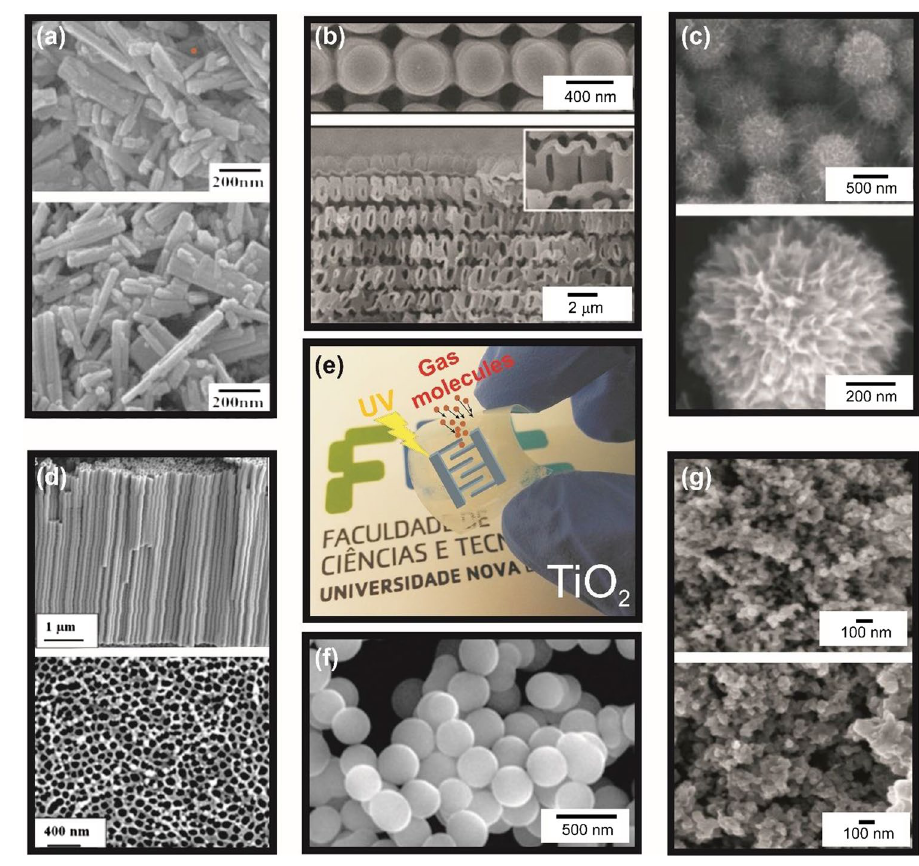
Fig. 2 SEM images of several TiO nanostructures 2 employed as sensing layers. a TiO nanotubes for toluene 2 sensing [57], b highly periodic 3D thin-shell TiO nanostruc- 2 tures for NO gas sensing 2 [58], c TiO 3D hierarchical 2 nanostructures for ethanol gas sensing [59], d TiO tubu- 2 lar layers for NO gas sensing 2 [60], e image representing a flexible sensor device adapted from [34], f TiO nanospheres 2 for ethanol and acetone gas sensing [61], g TiO nanopar- 2 ticles for NO gas sensing [62]. 2 Reprinted with permission from “Large scale synthesis and gas-sensing properties of anatase TiO three-dimen- 2 sional hierarchical